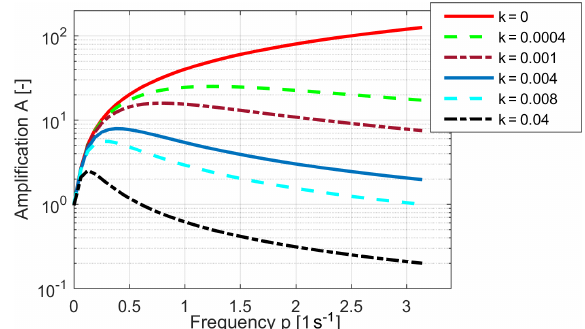
Figure 6. Temperature profiles through the three restored images compared with the original blurred one in Fig.